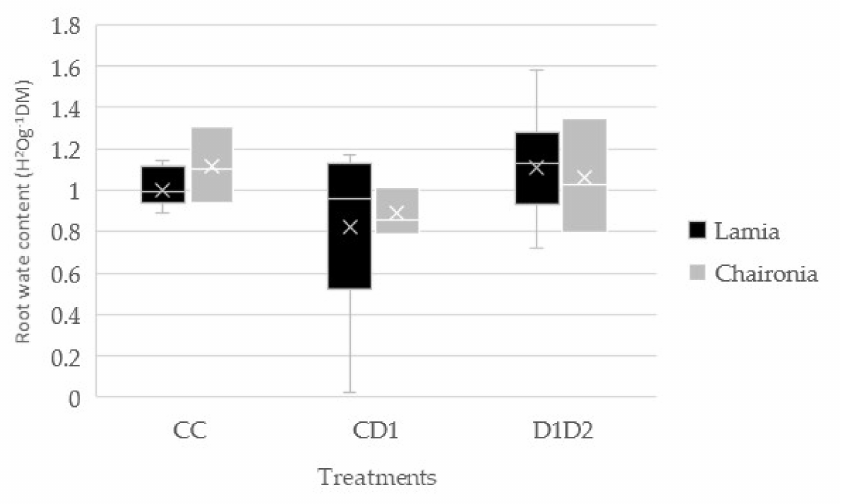
Figure 5. Root water content expressed as g of water per g of dry root weight. Bars show the mean of the biological replicates ± SE on day 133. There were no significant di ff erences among the